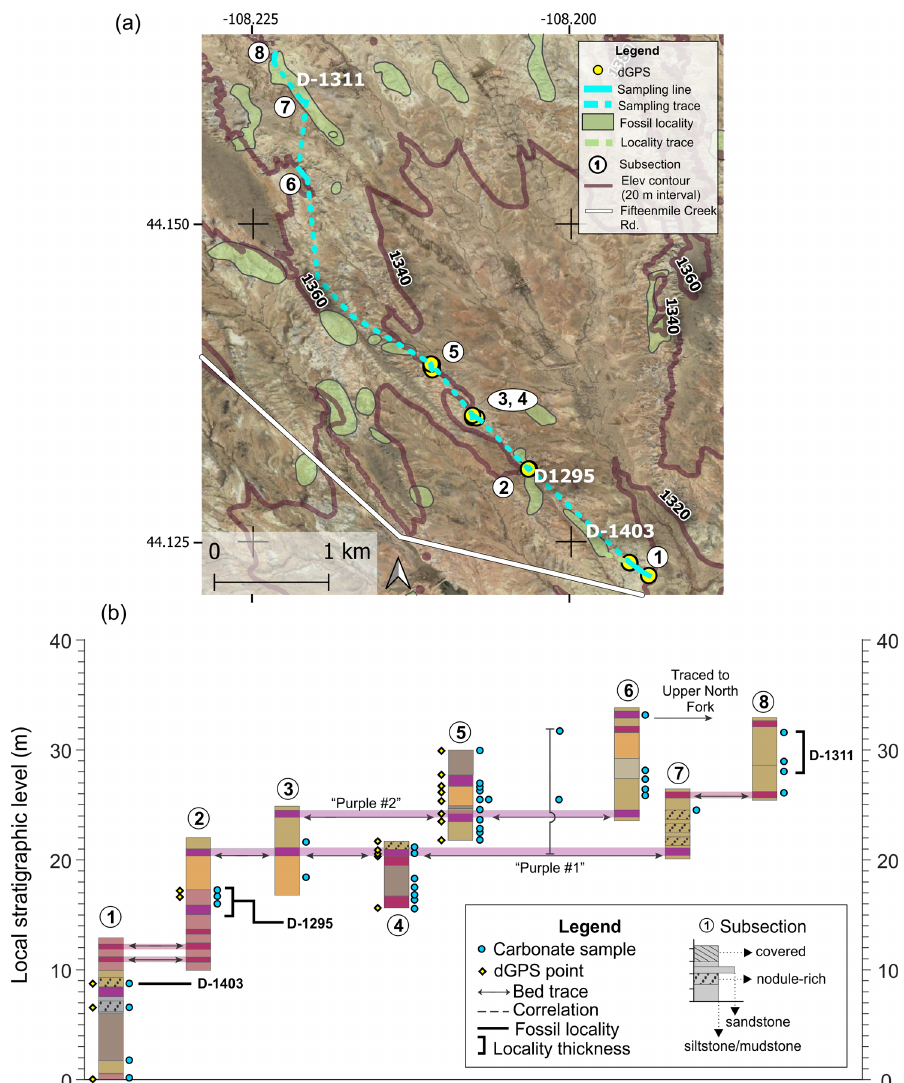
Figure A4. North Fork section (a) map and (b) diagram showing sampling subsections, dGPS tie points, bed traces, and correlated fossil localities. Colored boxes in (b) represent the surface color of weathered rocks. Marker beds used to trace between subsections are shown in light shading with arrows along the bed surface used for tracing. Basemap source: Google Earth © 2021. A high-resolution map is available in the supplemental data repository (Widlansky et al.,